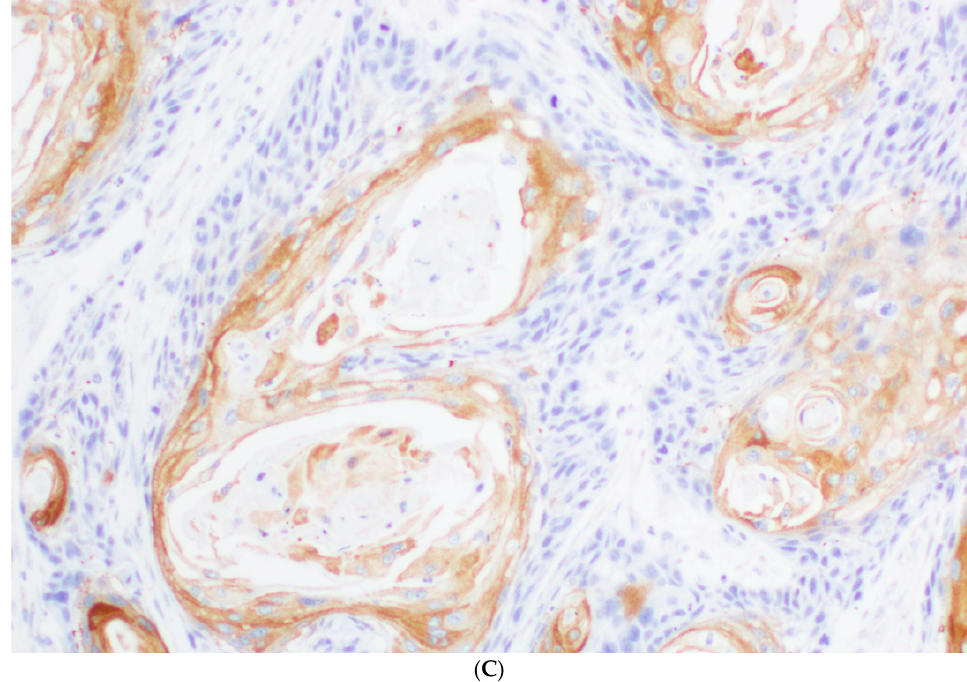
Figure 1. Immunoexpression of ZFAND4 in oral squamous cell carcinoma. ( A ) Staining in undifferentiated areas (arrow) and differentiated areas (*). ( B ) Staining in undifferentiated cells, mainly located in the invasive front of tumor tissue. ( C ) Staining in differentiated cells located at the center of the tumor islands.